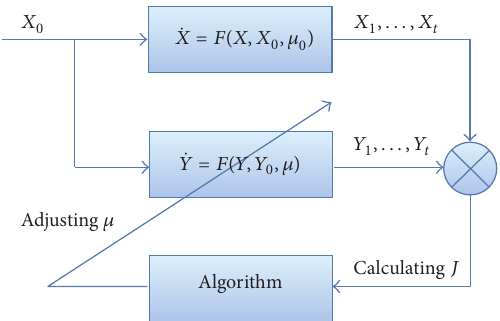
Figure 1: The principle of parameter estimation for a nonlinear